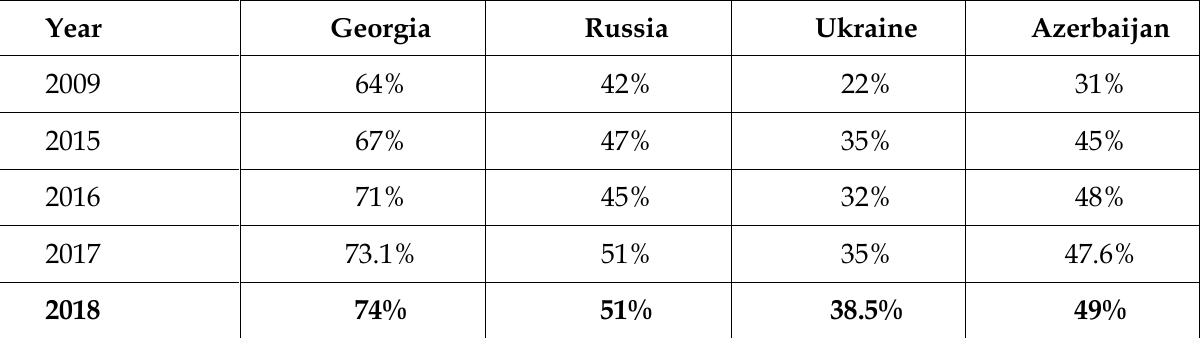
Table 1: Government Effectiveness Indicators throughout the Years, Worldwide Governance Indicators (WGI), World